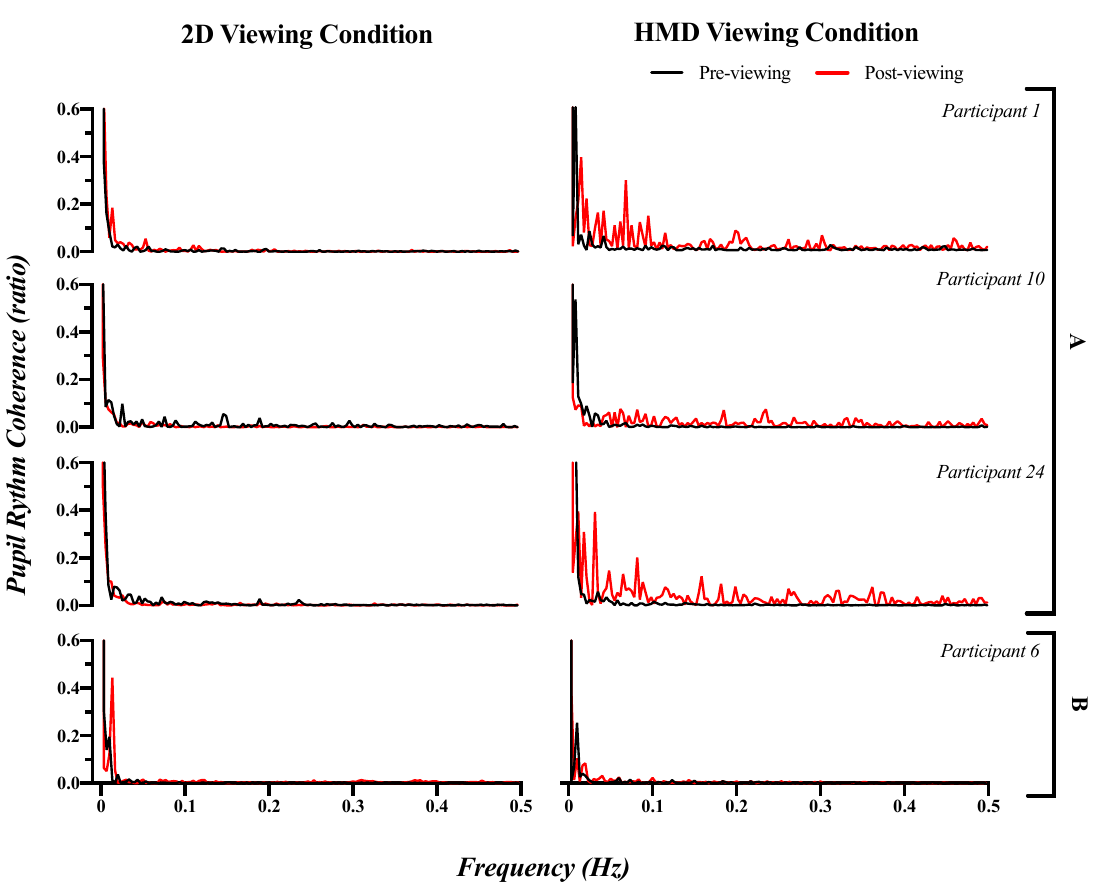
Figure 6. ( A ) Clear (for participants 1, 10 and 24) and ( B ) unclear examples (for participant 6) of changes in the spectrum of pupillary rhythms (PRC ratio) pre- and post-viewing 2D and HMD.